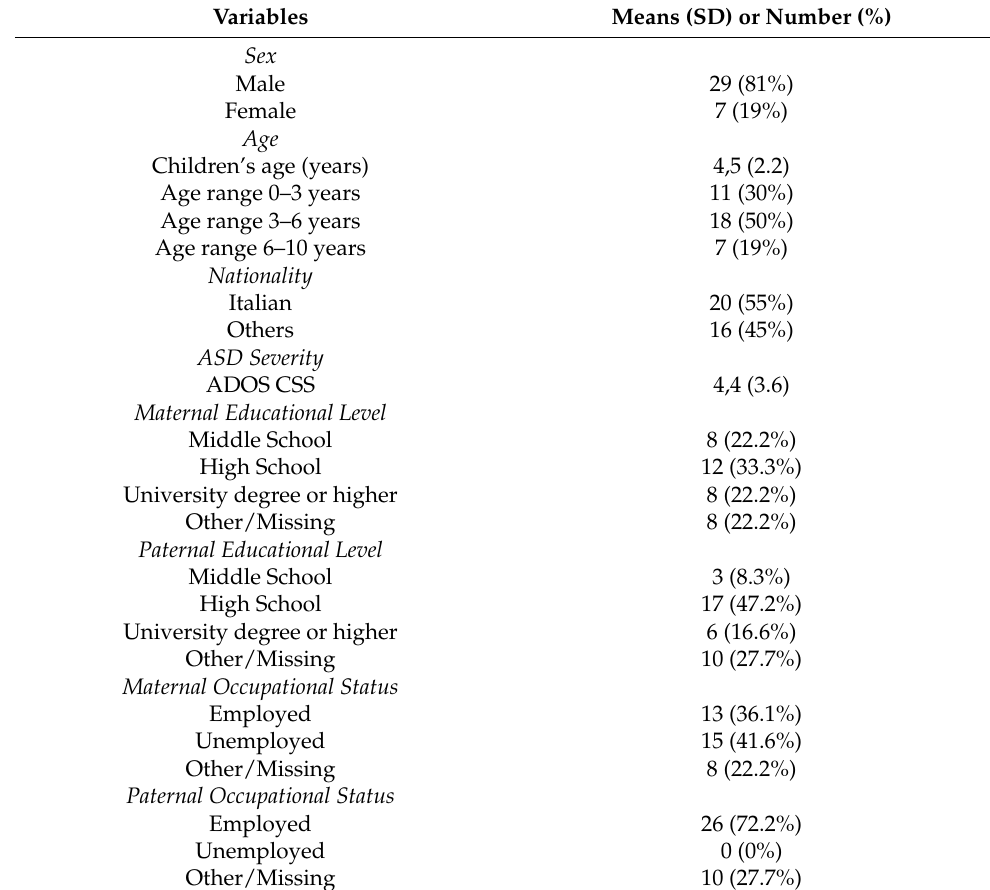
Table 1. Socio-demographic and clinical